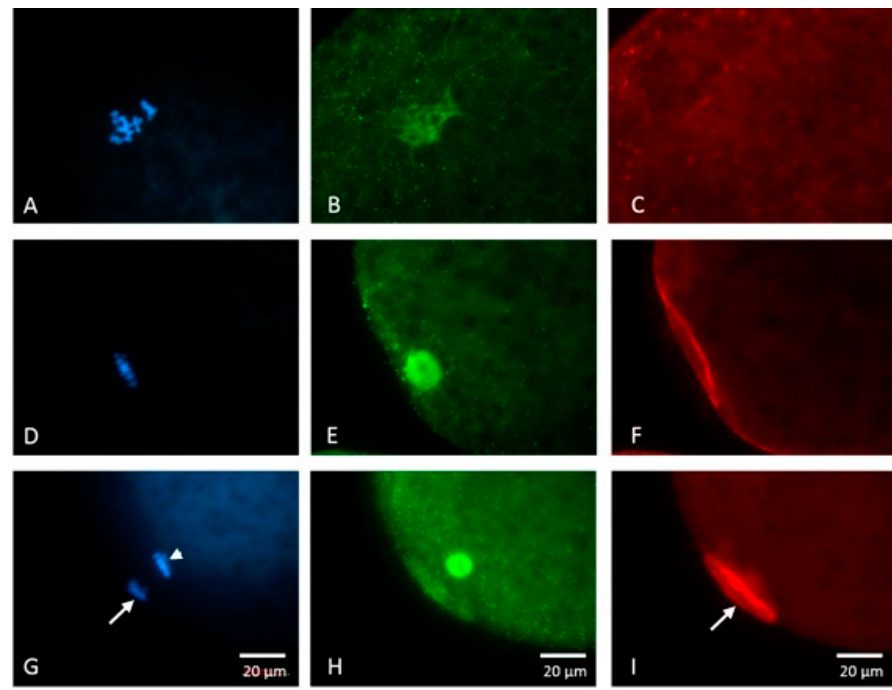
Figure 2. Nuclear and cytoskeletal dynamics of porcine oocytes during in vitro maturation (IVM). Germinal vesicle breakdown (GVBD) and chromatin condensed into chromosomes around 18 h after the onset of IVM ( A ). Microtubules transformed into a spindle-like structure in the ooplasm with little or no periplasmic microtubules ( B ) during which reduced microfilament intensity ( C ) was visible. In metaphase I (MI), chromosomes aligned on the equatorial plate ( D ). Meiotic spindle structure was formed by microtubules in the ooplasm, while microfilaments became thickened on the periooplasmic area near the MI spindle ( F ). ( G ) In the metaphase II (MII) stage, a polar body was extruded (arrow) and chromosomes realigned on the equatorial plate (arrowhead) with the formation of the MII spindle. ( H ) The intensity of microfilaments increased between the polar body and the matured oocyte, forming an actin cap-like structure ( I , arrow). Scale bar, 20 μ m.